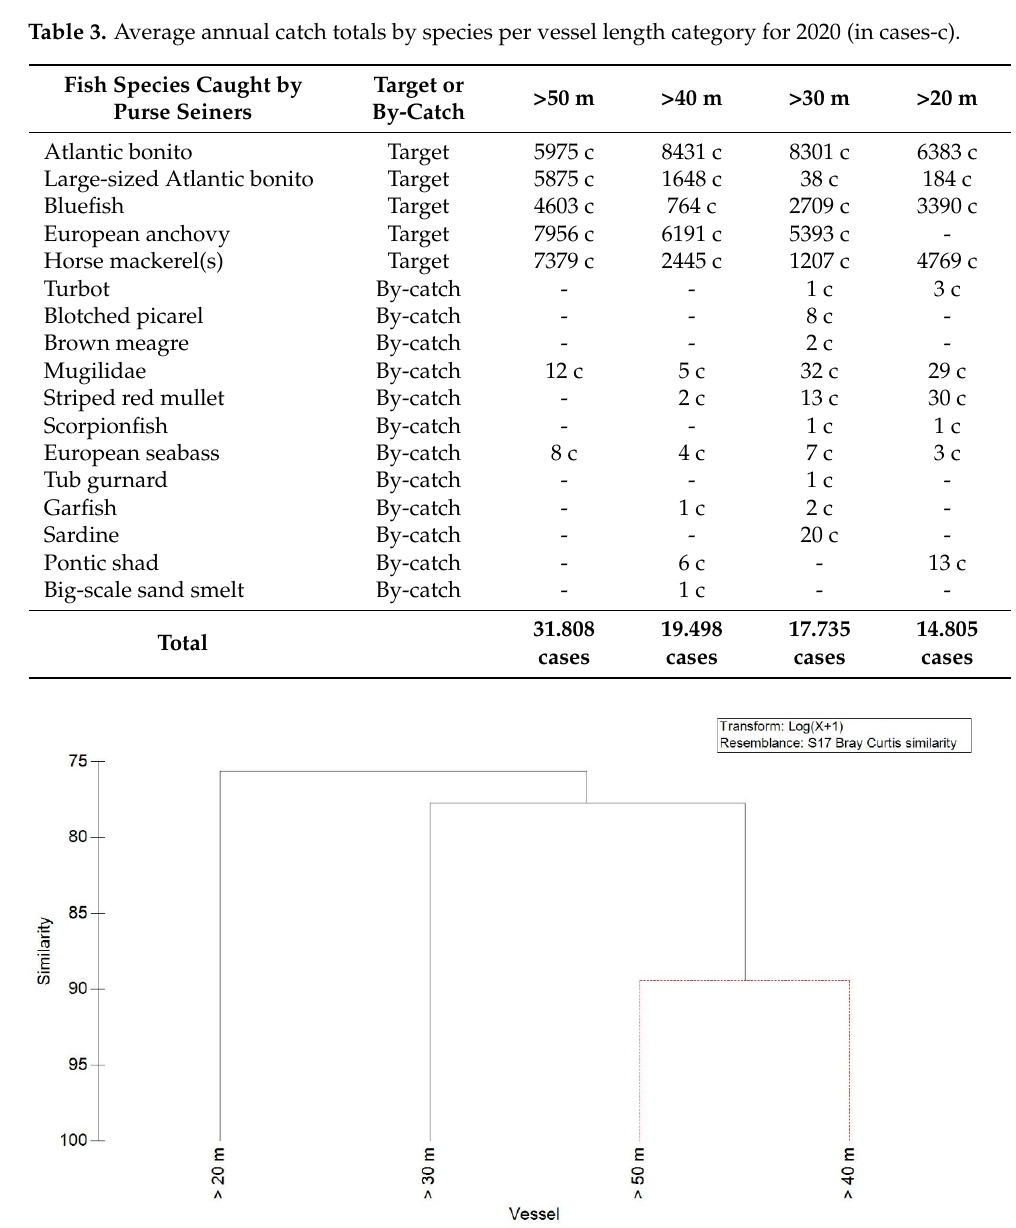
Figure 4. Hierarchical cluster dendrogram based on Bray-Curtis similarity: red dotted lines represent insignificant differences between vessel classifications by SIMPROF